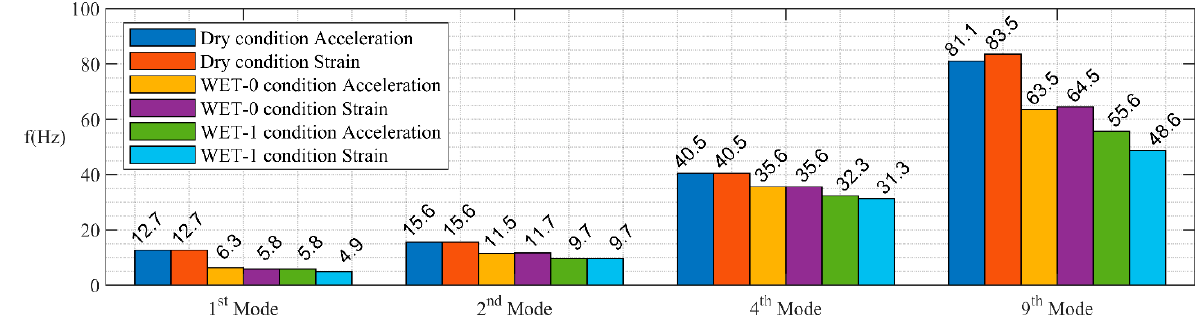
Figure 11. Comparison of NFs of the small-scale experimental model under various flood stages, extracted from acceleration and strain signals.